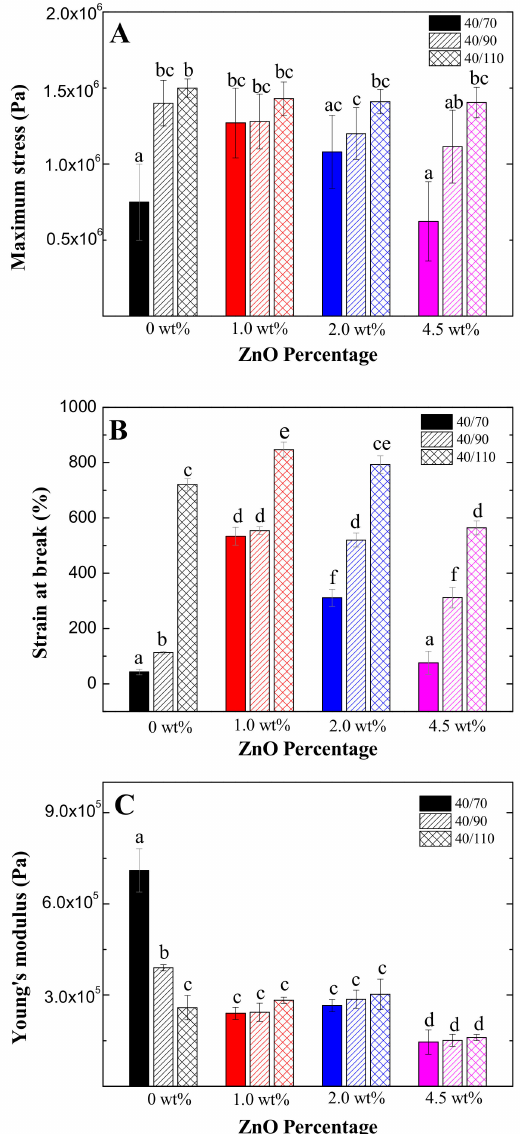
Figure 2. Tensile parameters of bioplastics with different ZnO nanoparticle concentrations (0 wt%, 1.0 wt%, 2.0 wt% and 4.5 wt%) processed at different mould temperatures (70 ◦ C, 90 ◦ C and 110 ◦ C). ( A ): maximum stress. ( B ): strain at break. ( C ). Young’s modulus. Different letters in the bars mean that the values are significantly different ( p <